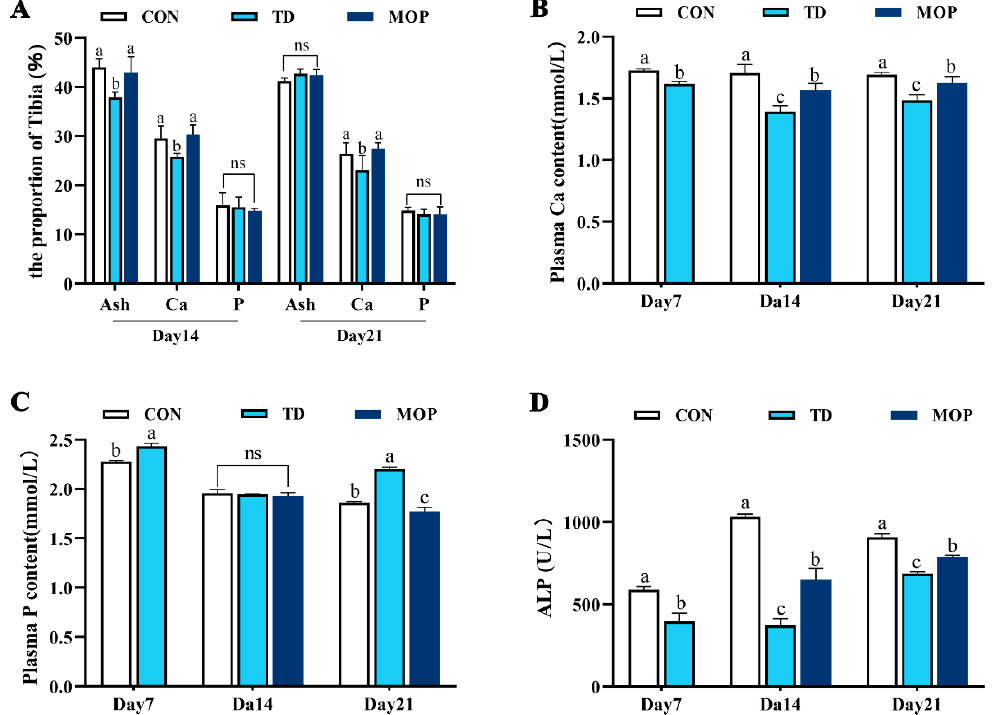
Figure 3. Effects of MOP on tibial ash, calcium (Ca) and phosphorus (P) levels and plasma bone metabolism indices of TD broilers. ( A ) The contents Ca, P, and ash in the tibia on days 14 and 21. ( B ) Plasma Ca content. ( C ) Plasma P content. ( D ) Plasma alkaline phosphatase (ALP) levels. Bars with no common small letters (a, b, c) indicate statistical differences among the three treatments ( p < 0.05). ns showed no statistical significance among the three treatment groups ( p > 0.05).